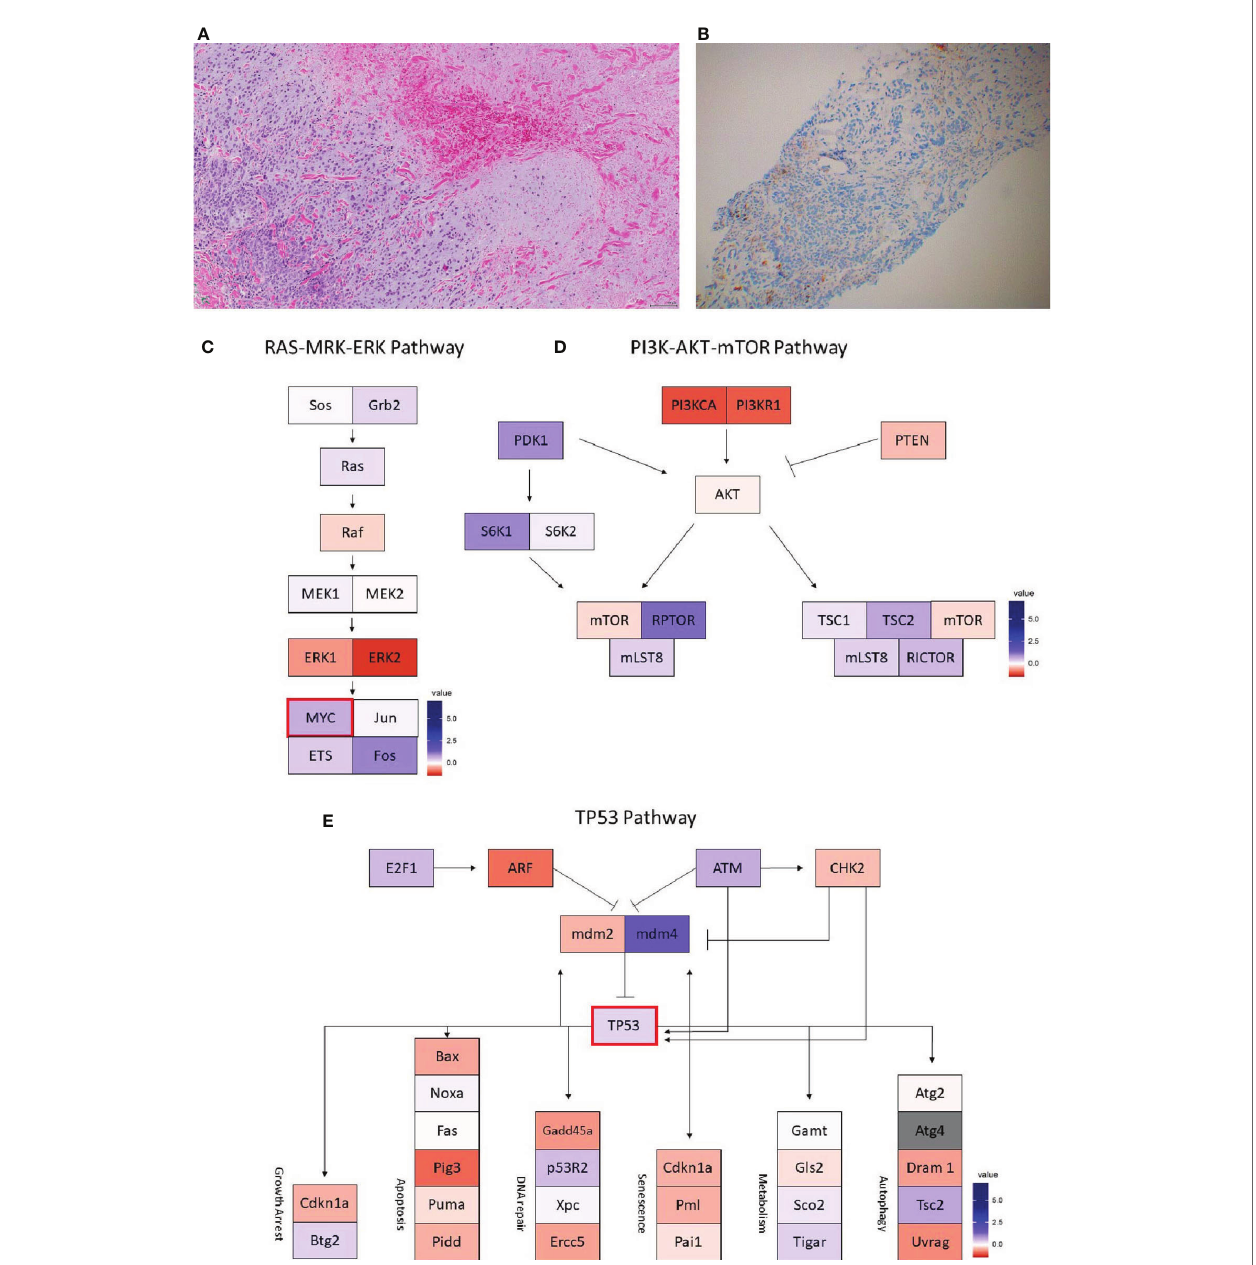
FIGURE 5 | Case 5 (A) H&E image, showing metaplastic squamous carcinoma (B) PD-L1 by the Ventana PD-L1 SP263 assay. Images (C – E) show RNA expression heatmaps with modi fi ed z-scores of expression vs. non-metaplastic TNBC cases in pathways of interest for metaplastic breast cancer (C) RAS-MEK- ERK, (D) PI3K-AKT-mTOR (E) TP53. Genes with DNA mutations are outlined in